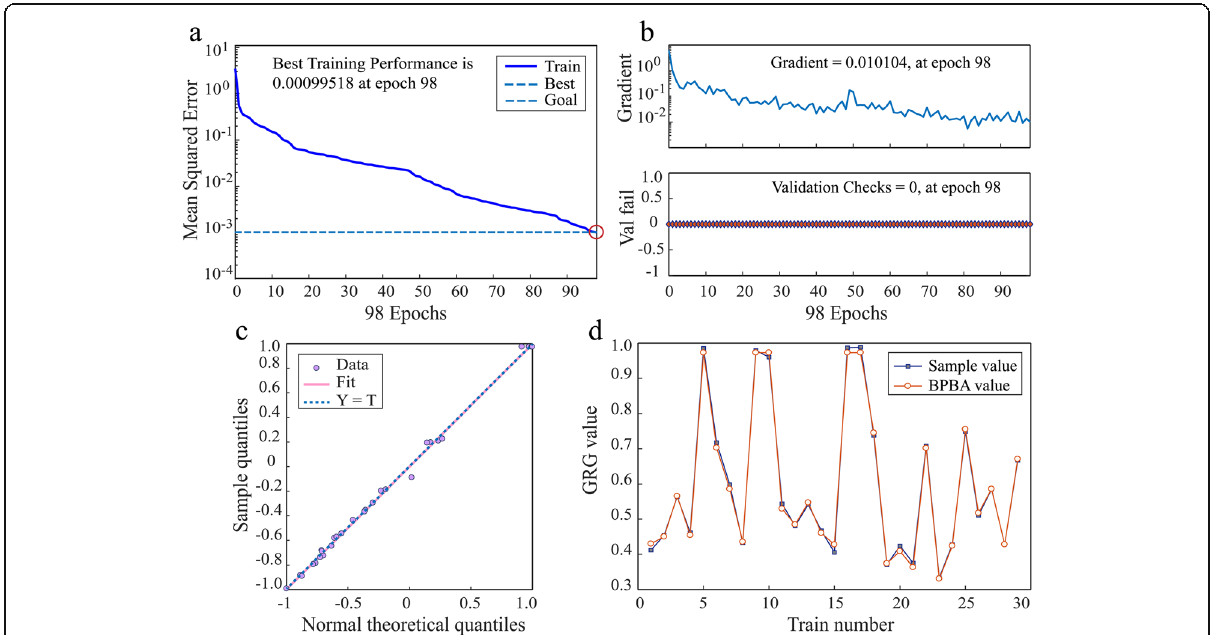
Fig. 5 The training process and results of backpropagation neural network. a The error curve of GRG in BP network training process. b Error curve of training process. c Normal quantile-quantile plot. d Comparison of measured value and prediction